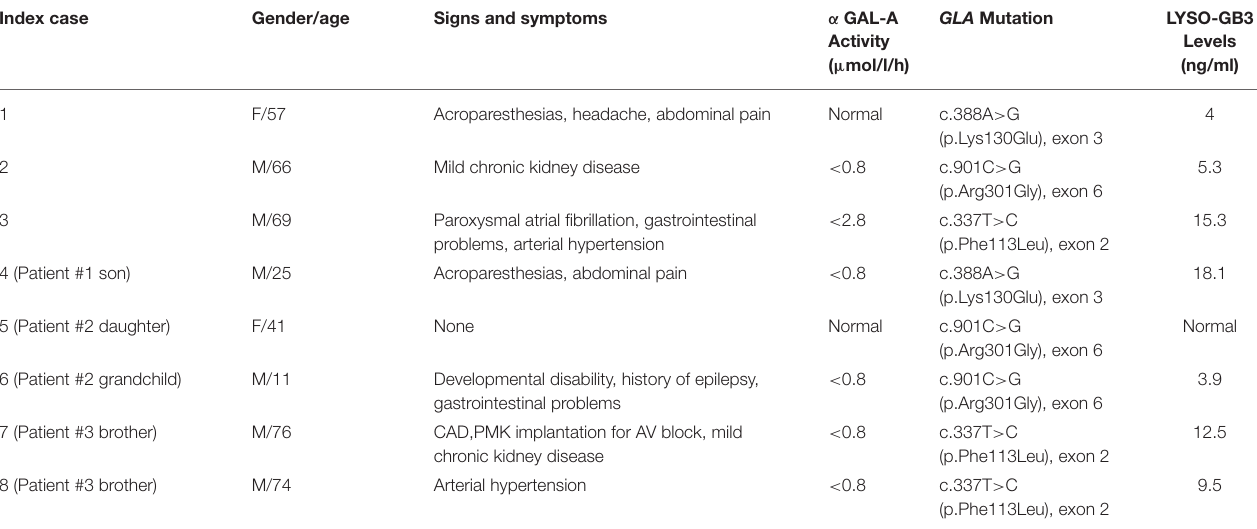
TABLE 3 | Clinical and molecular data of the three FD cases and their